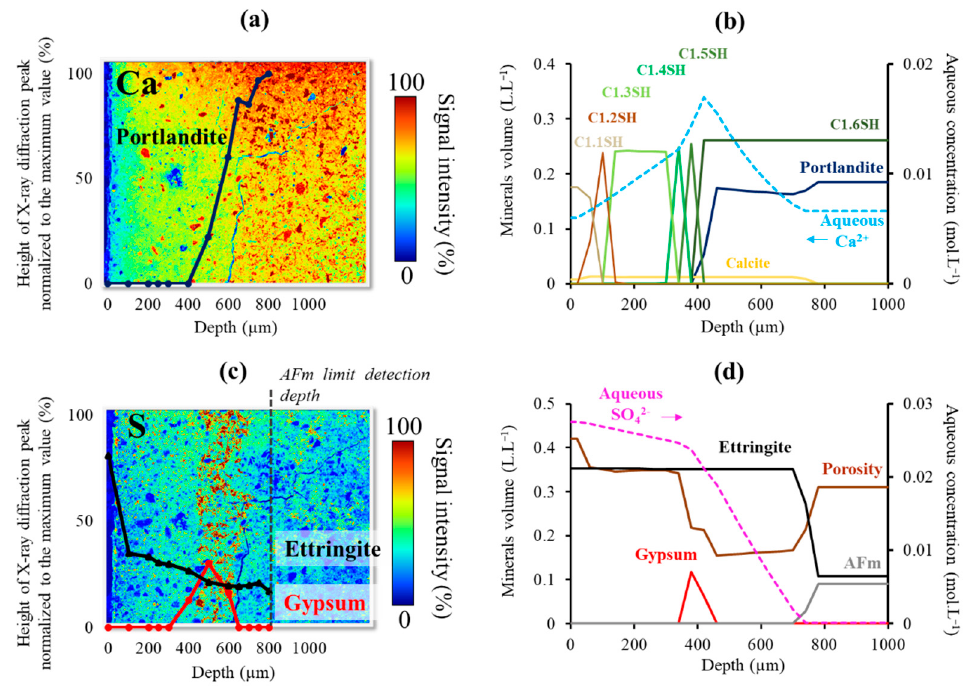
Figure 2. Elementary SEM–EDS maps of Ca with the mineralogical profile of portlandite obtained by XRD ( a ) and elementary SEM–EDS map of S with XRD mineralogical profiles of ettringite and gypsum ( c ) obtained after 60 days of degradation. Simulation results of the cement paste decalcification ( b ) and sulfate products precipitation ( d ) at 60 days.